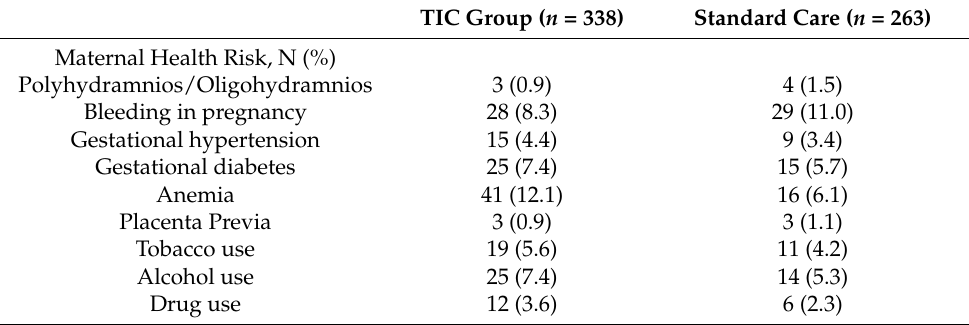
Table A1. Frequency of health risk difficulties for TIC Vs. Standard Care